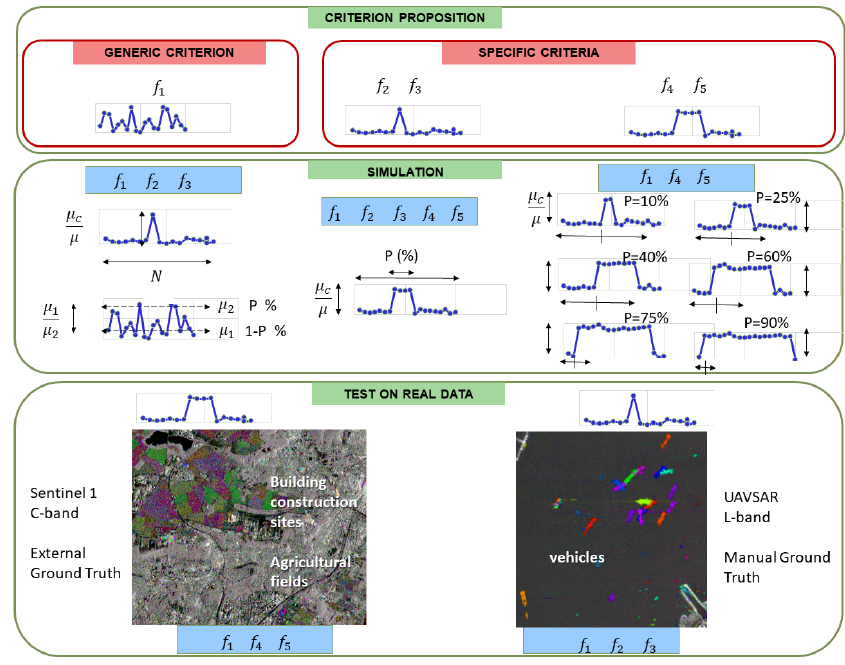
Figure 2. Synopsis for the article: Criteria, Simulations, and real